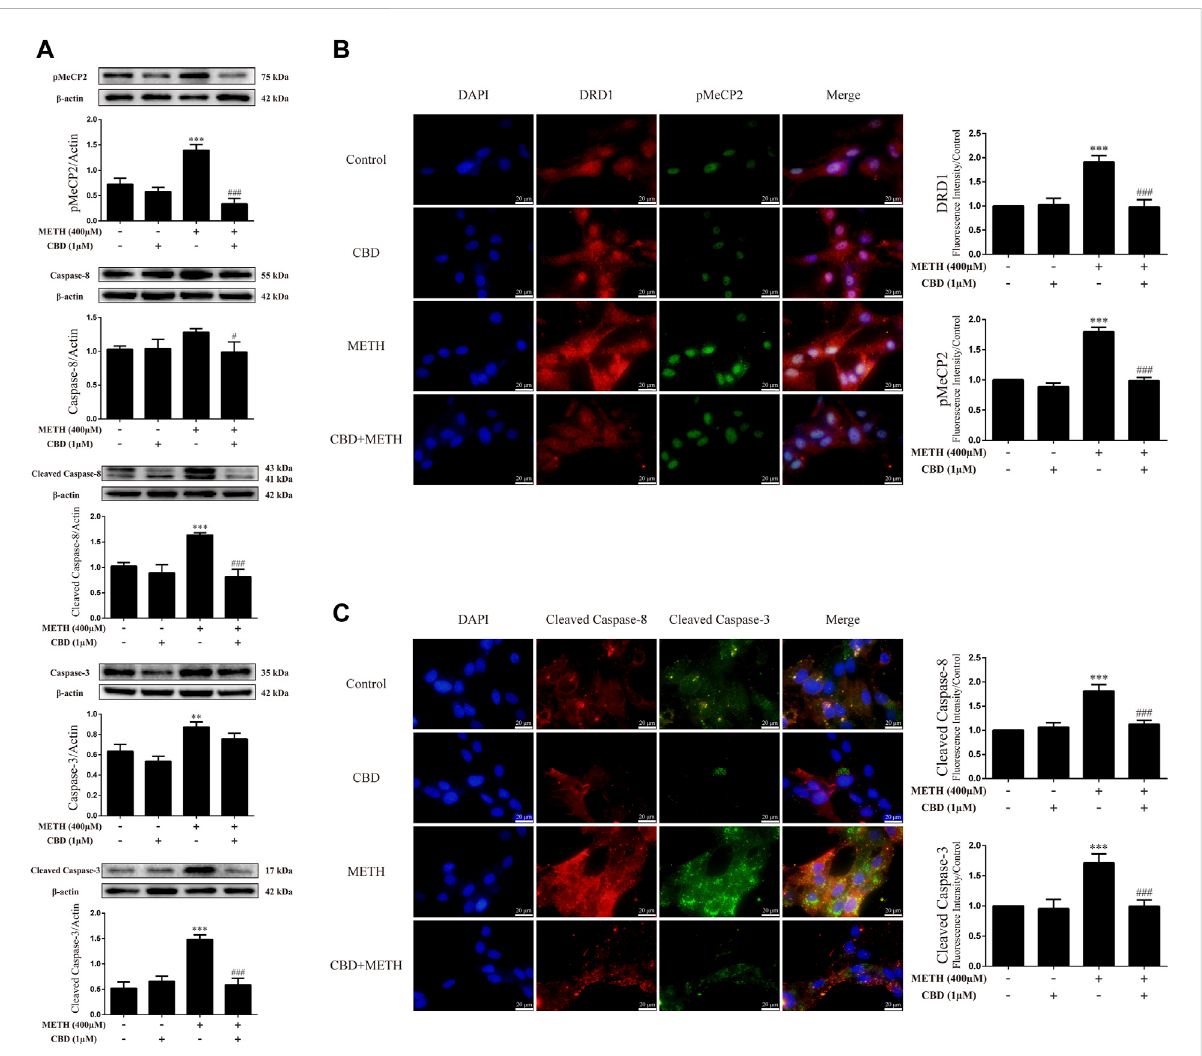
FIGURE 3 Protein levels and colocalization in neurons incubated with CBD and/or METH. (A) Levels of pMeCP2 and apoptosis-related proteins. (B) DRD1 and pMeCP2 levels and their colocalization. (C) Cleaved caspase-8 and cleaved caspase-3 levels and their colocalization. ** p < 0.01 or *** p < 0.001comparedwithcontrolgroup, # p < 0.05or ### p < 0.001comparedwithMETHgroup;TukeyHSD post-hoc comparisonaftersigni fi cant